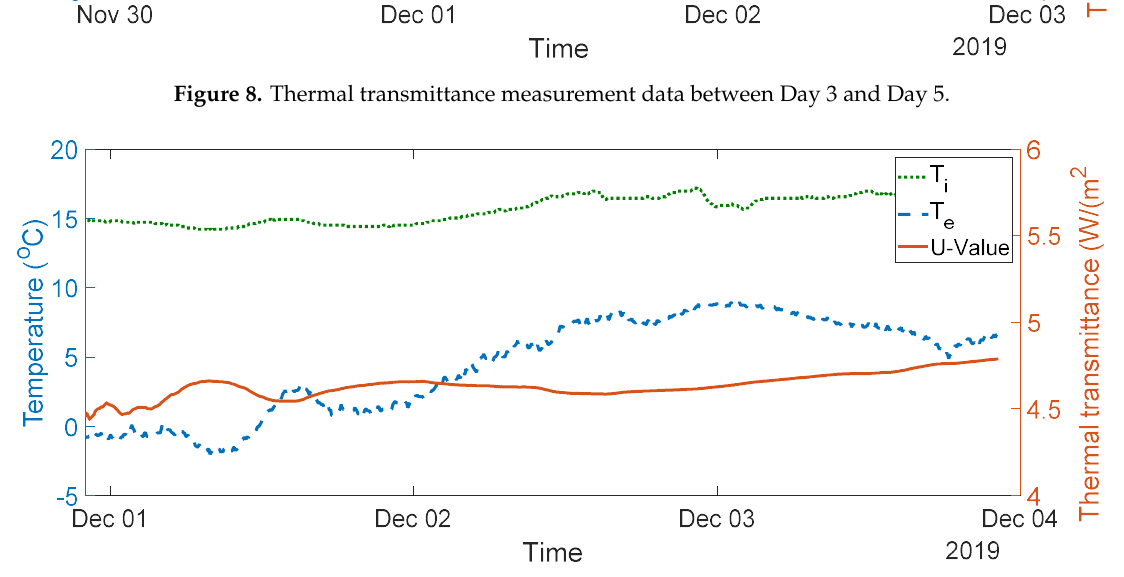
Figure 9. Thermal transmittance measurement data between Day 4 and Day 6.